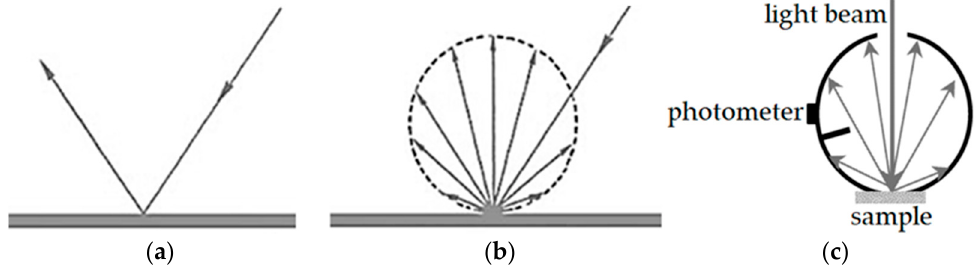
Figure 1. Specular reflector ( a ), diffuse reflector ( b ), and integrating sphere ( c ). ASTM E903 [35] is a widely appreciated standard test method that relies upon the use of a spectrophotometer with an integrating sphere to measure the spectral reflectance of the test sample over the entire range from 300 nm to 2500 nm. The first version of the standard dates back to 1996 and was implemented into the CRRC rating program in 1998. Entering into details, it is used to measure near normal-hemispherical solar reflectance, i.e., reflectance with irradiance almost normal to the sample surface and flux leaving the surface collected, in order to detect the radiation intensity, over an entire hemisphere. A double-beam spectrophotometer is recommended, as well as an integrating sphere with a minimum diameter of 150 mm. The acquired spectrum of solar reflectance is finally av- eraged over the measurement range, being weighted by a spectrum of solar irradiance at the earth surface according to Equation (1). Some solar spectra are provided in previous studies [35]; nevertheless, the choice of the reference spectrum is not so obvious. therefore, on the latitude, the time of the year and the time of day. It also depends on the solid angle it comes from, distinguishing between: